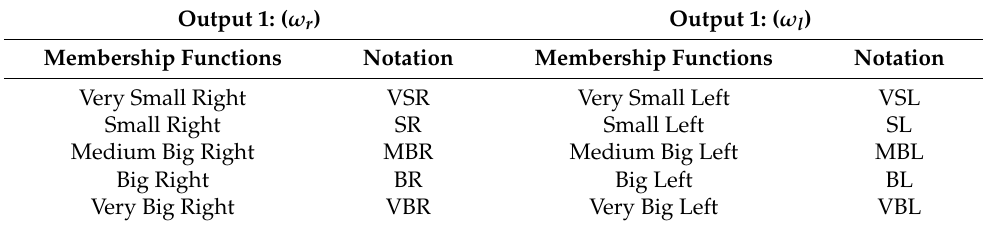
Table 3. The output membership functions.